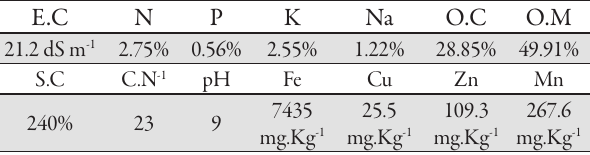
Tab. 2. Fresh cattle manure